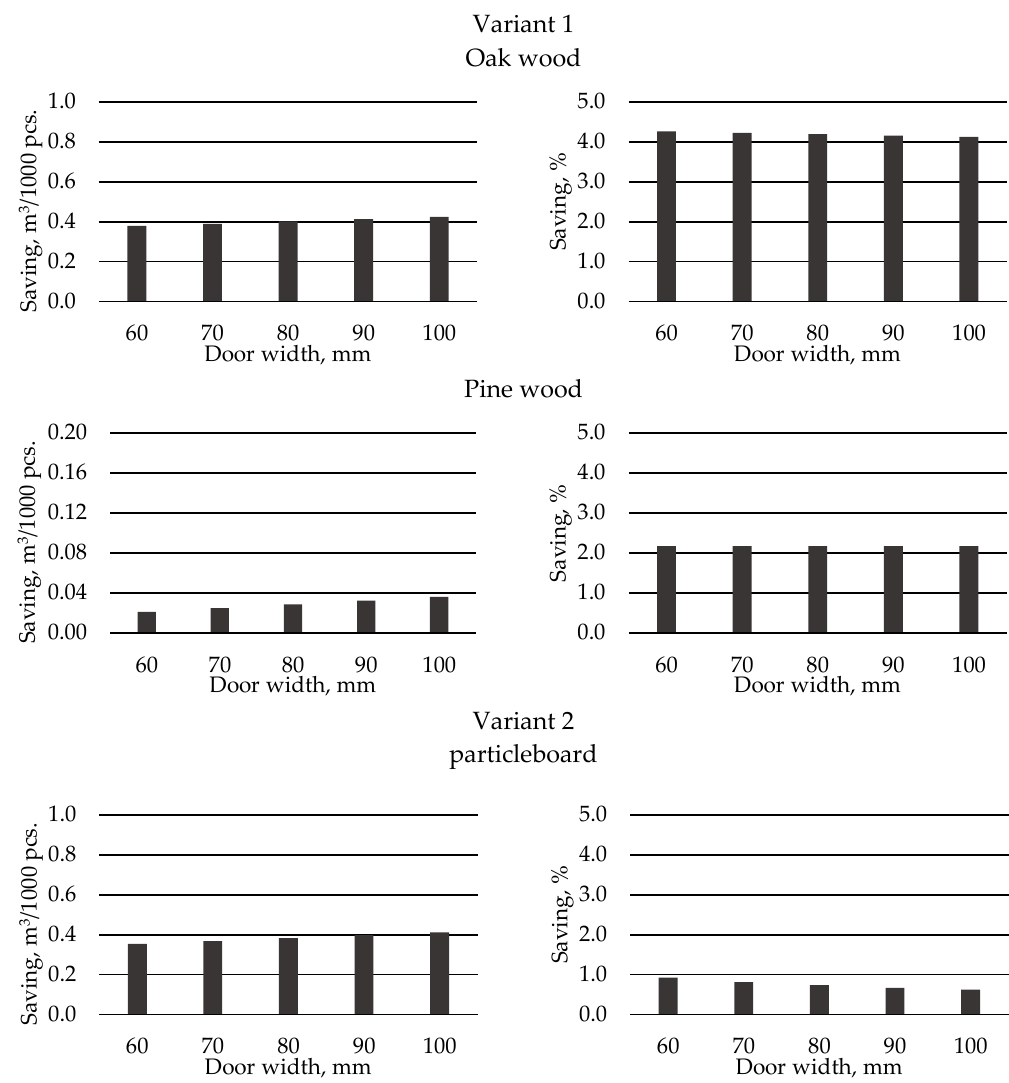
Figure 9. Material savings obtained by reducing the machining allowance in construction 3.